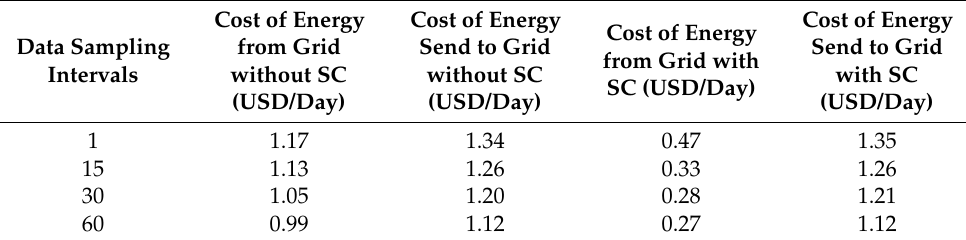
Table 4. Daily cost of energy to/from the utility